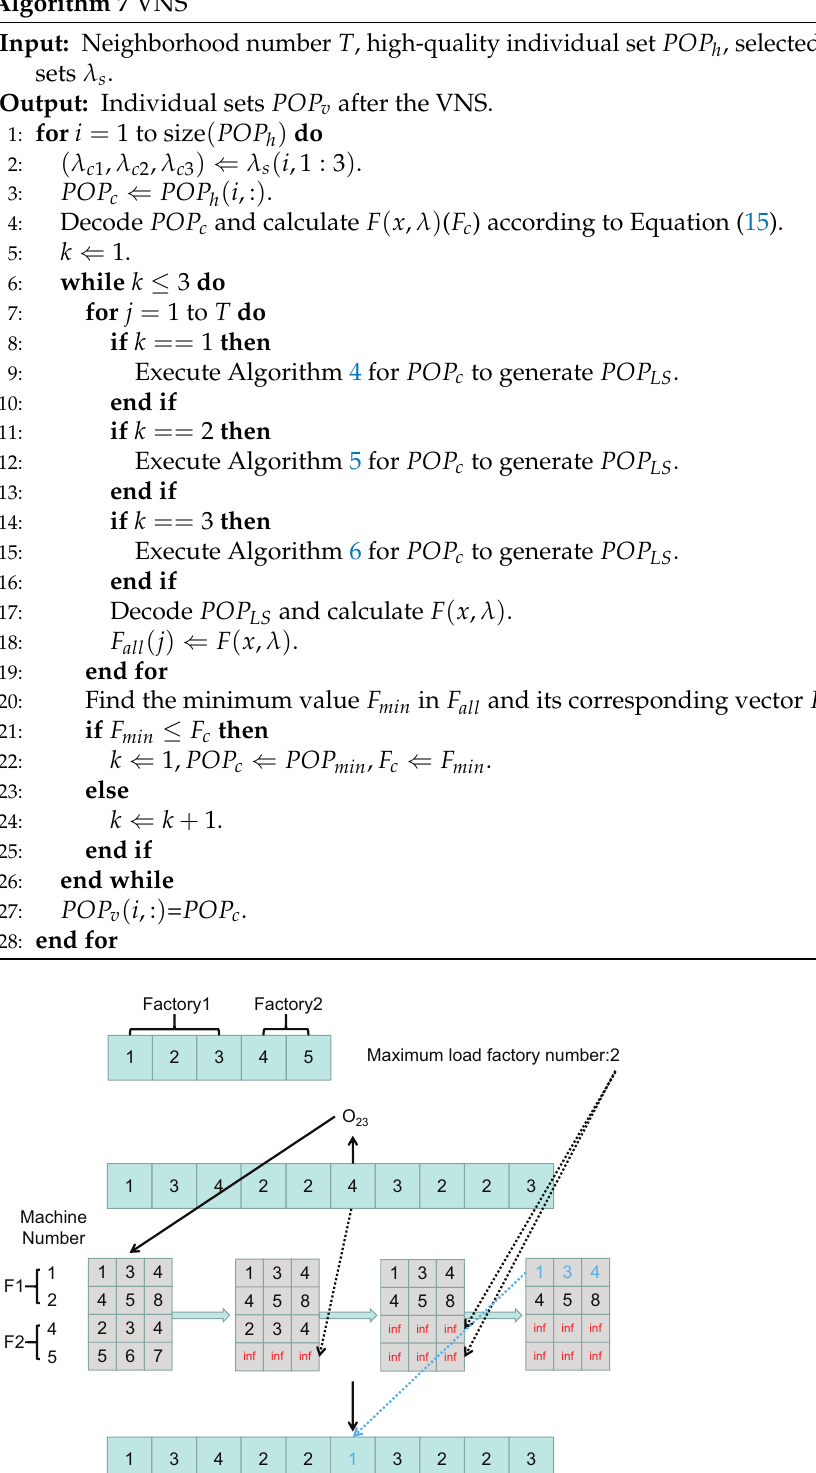
Algorithm 7 VNS